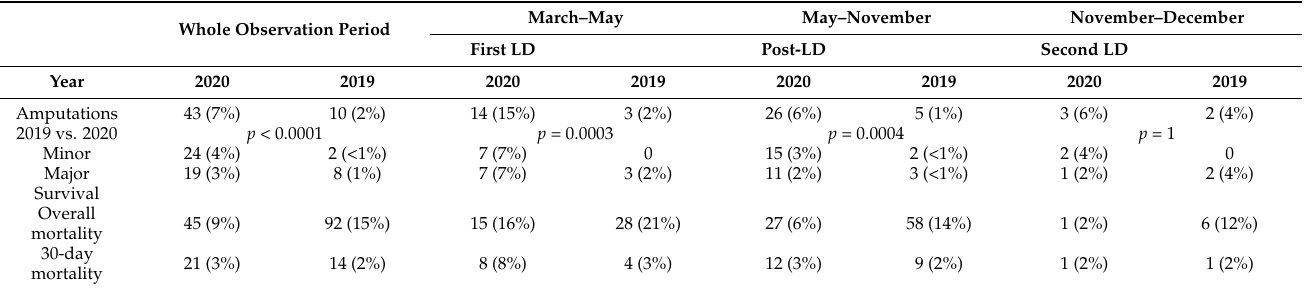
Table 3. Number of limb amputations and survival in patients with peripheral artery